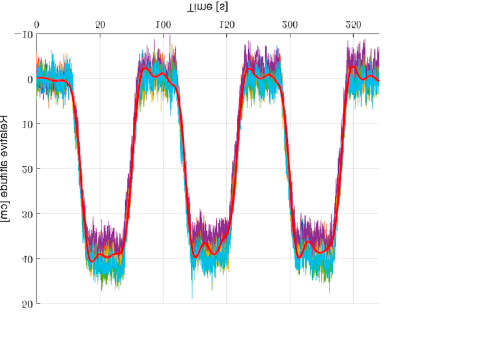
Figure 11. ( a ) Graph over time from 6 + 1 sensors, a bold graph calculated from the average of individual sensors, and ( b ) histogram. Dynamic measurements—sensor array in motion.